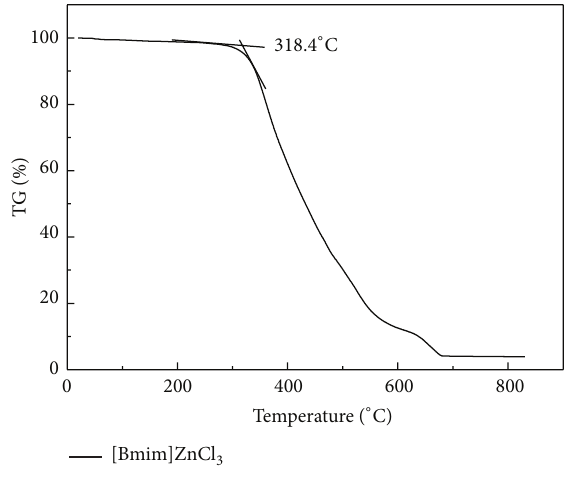
Figure 6: TG curve of [Bmim]ZnCl 3 .